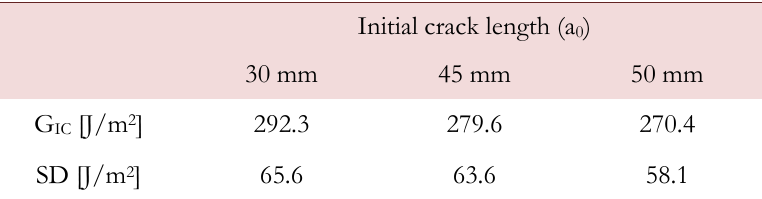
Table 1: G IC values versus delamination